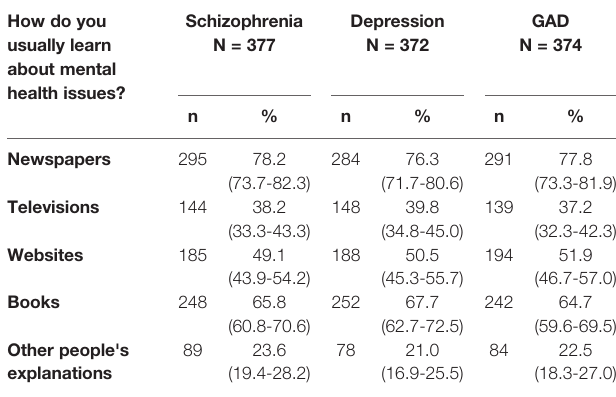
TABLE 5 | Usual source of mental health knowledge of